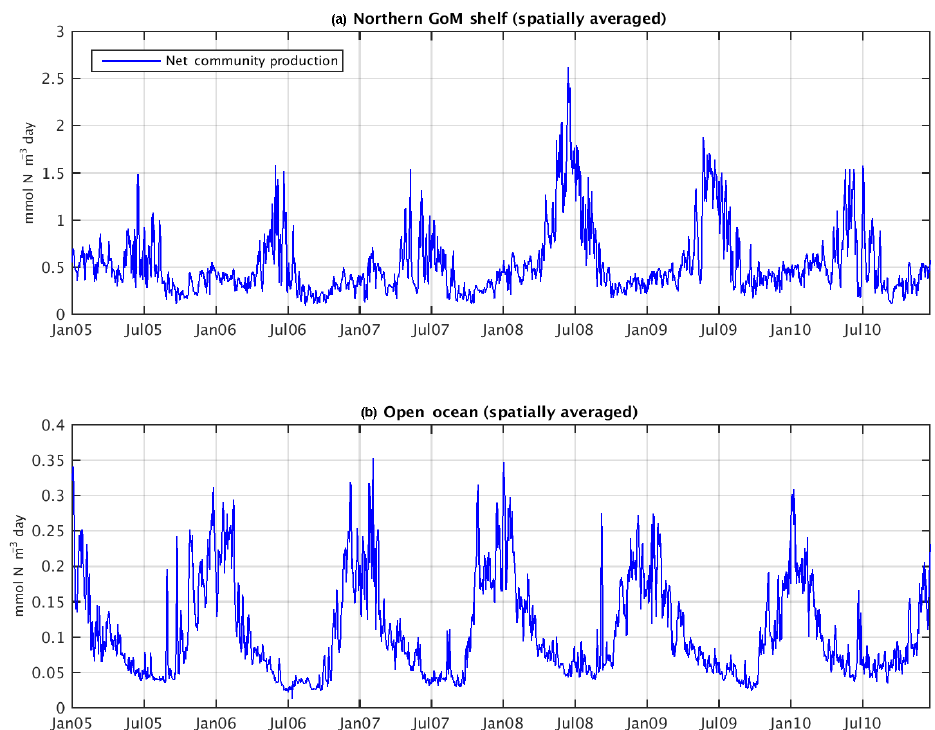
Figure 9. Time series of spatially averaged net community production (a) on the Northern Gulf of Mexico Shelf and (b) in the entire Gulf of Mexico (unit: mmolNm − 3 )